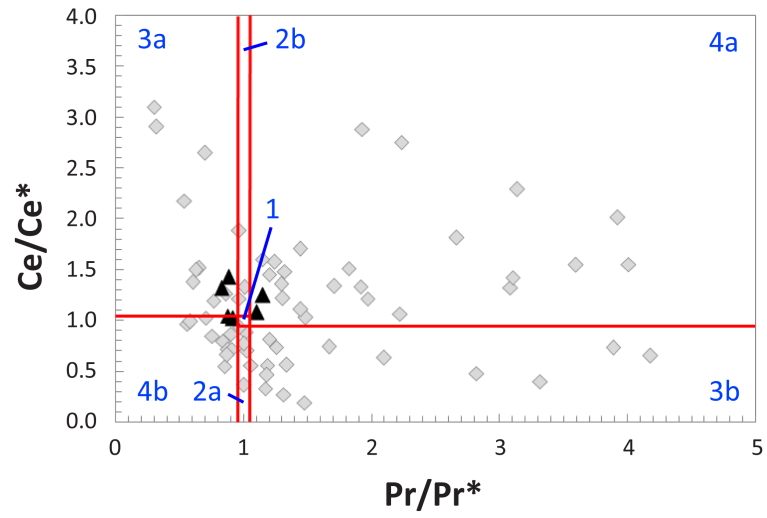
Figure 6. (Ce/Ce*) N vs. (Pr/Pr*) N plot (after [84]) of five-point averages along the transect across the cortex of MOR 2598 recorded via LA-ICPMS. Separate fields (labeled by blue text) are as follows: 1, neither Ce nor La anomaly; 2a, no Ce and positive La anomaly; 2b, no Ce and negative La anomaly; 3a, positive Ce and negative La anomaly; 3b, negative Ce and positive La anomaly; 4a, negative Ce and negative La anomaly; 4b, positive Ce and positive La anomaly. Measurements from the outer 1 mm of the external cortex are plotted as black triangles, and all measurements from deeper within the bone are plotted as gray diamonds. (Ce/Ce*) N and (Pr/Pr*) N anomalies calculated as in the Materials and Methods section of the text.